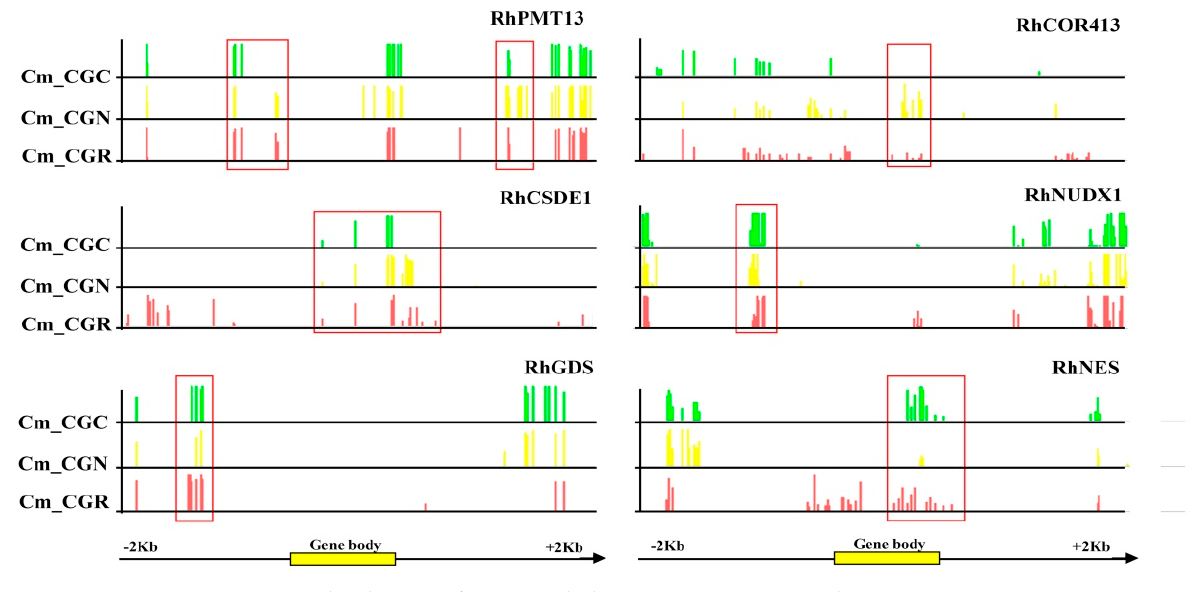
Figure 7. The changes of DNA methylation in DMR-associated genes.